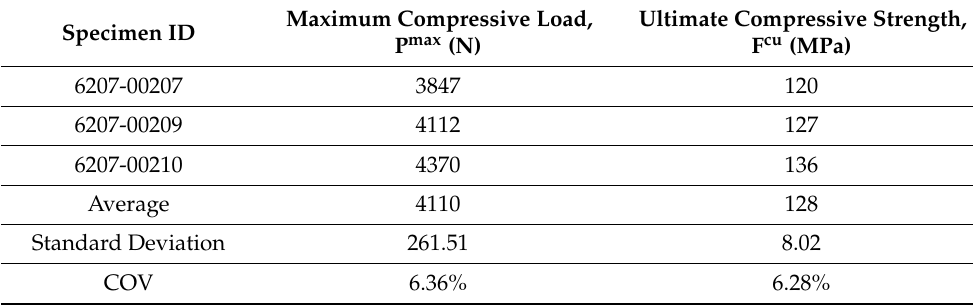
Table 1. Summary of mechanical properties of multifunctional carbon fiber composites.